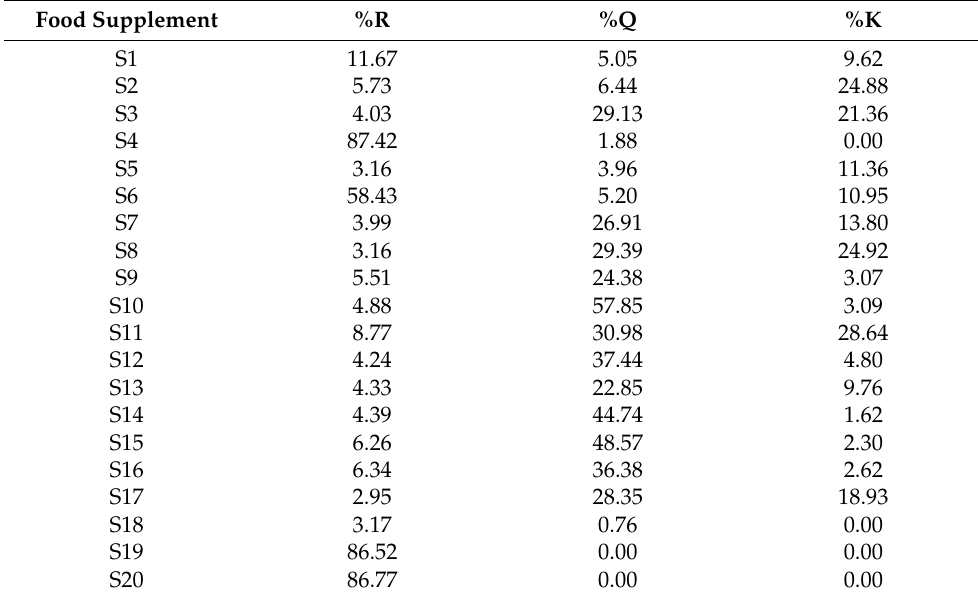
Figure 2. Hierarchical cluster analysis based on chromatographic data after mean center preprocessing. Ward’s method of agglomeration with Euclidean distance was used. Table 1. Percentage contribution of the rutin (R), quercetin (Q), and kaempferol (K) peak area in the total chromatogram area for food supplements.